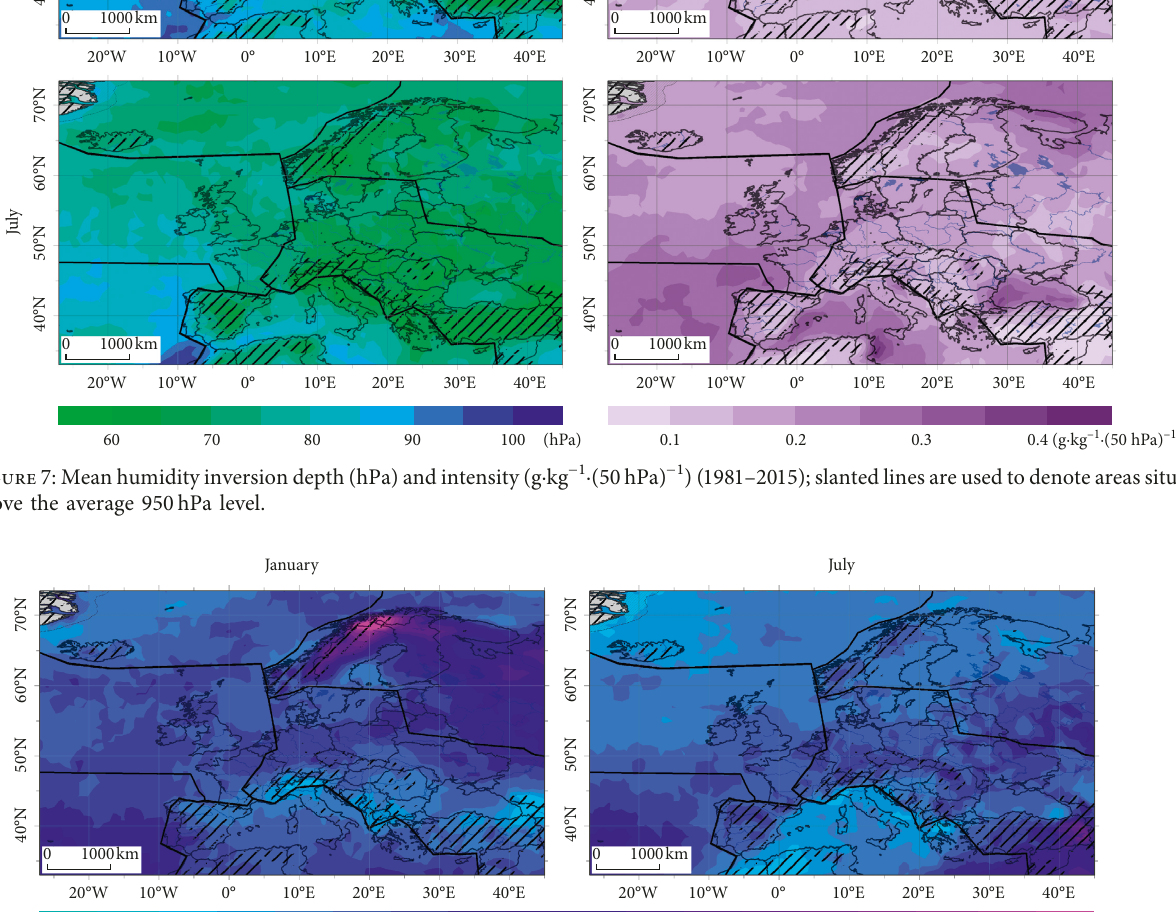
Figure 8: Mean standardized humidity inversion intensity (g above the average 950hPa